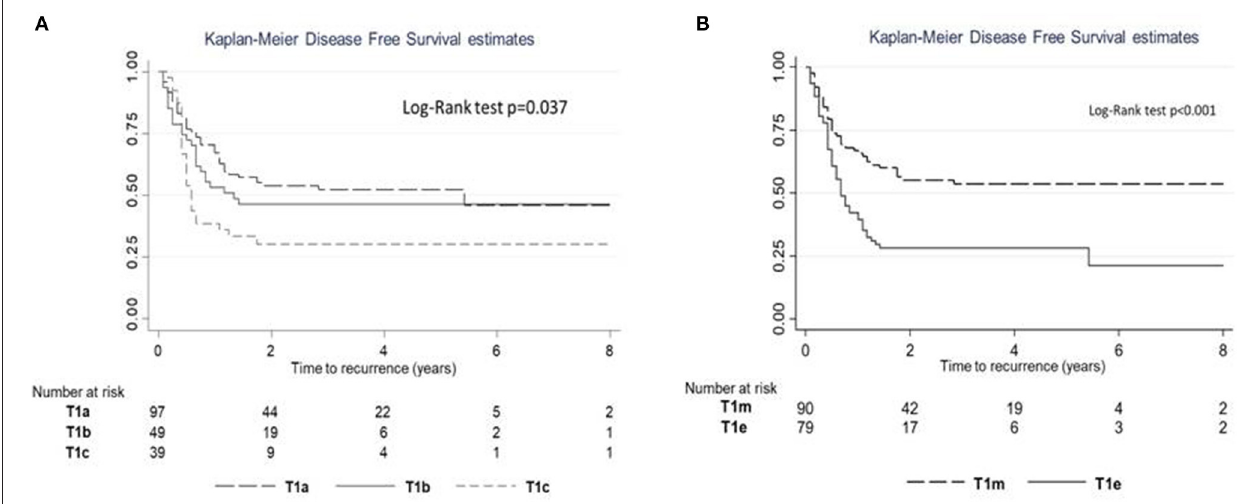
FIGURE 2 | Recurrence-free survival (RFS) estimates according to subcategory. (A) RFS for subcategories T1a–c. (B) RFS for subcategories T1m–e.